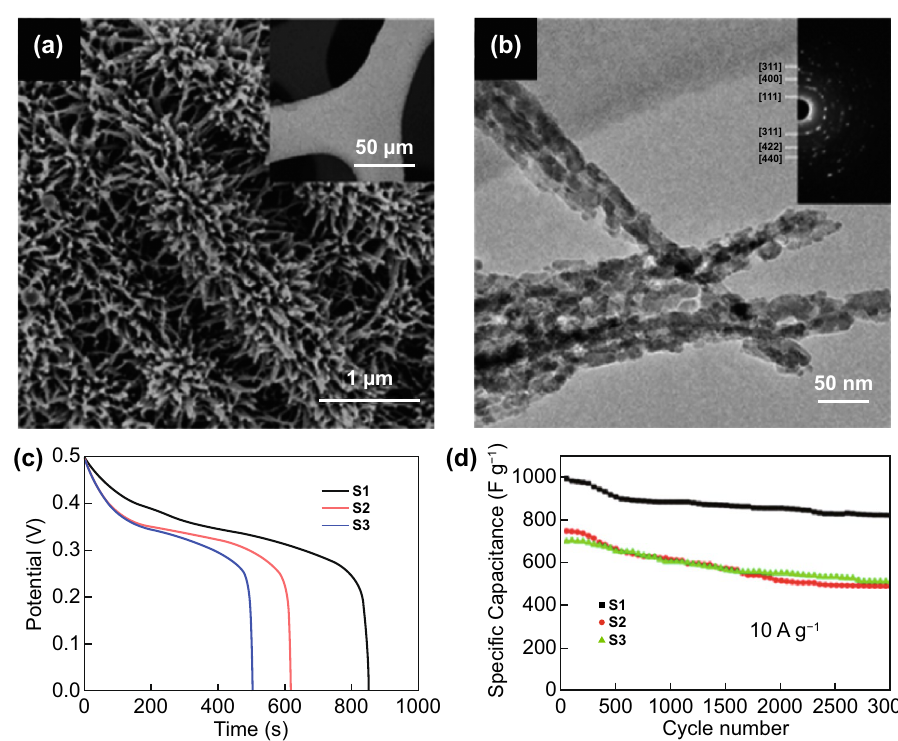
Fig. 7 a SEM images of NiCo 2 S 4 /NF. b TEM image of nanowires from NiCo 2 S 4 NSNWs; the inset in (b) shows SAED pattern, c GCD curves at 1 A g –1 , and d Stability at 10 A g –1 of the S1, S2, and S3 electrodes. Reproduced with permission from Ref. [126]. Copyright 2017, ACS Pub-